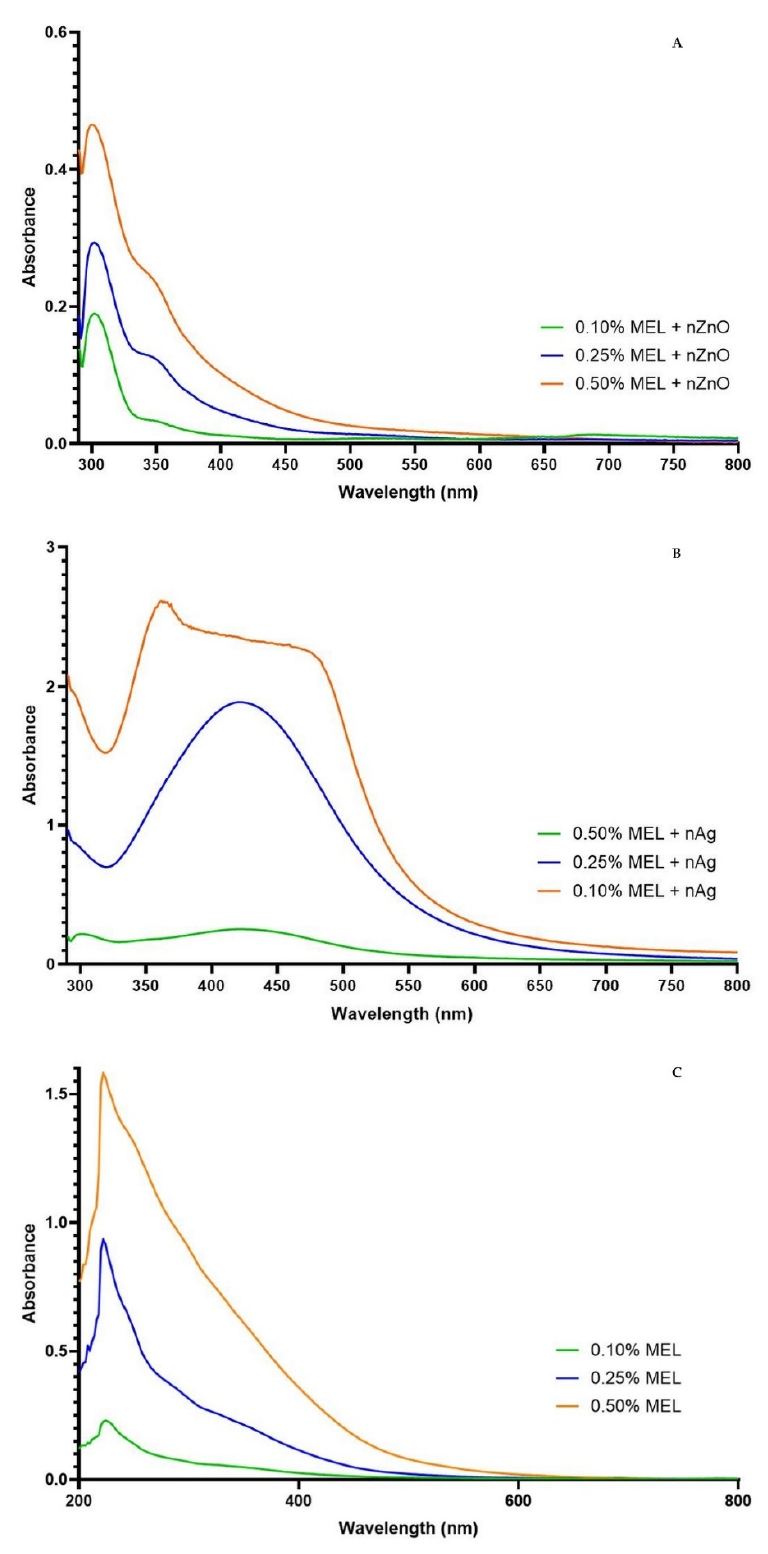
Figure 1. UV-Vis spectra of obtained zinc oxide nanoparticles ( A ), silver nanoparticles ( B ) samples, UV-Vis spectra of C. lanatus melanin at different concentrations for comparison ( C